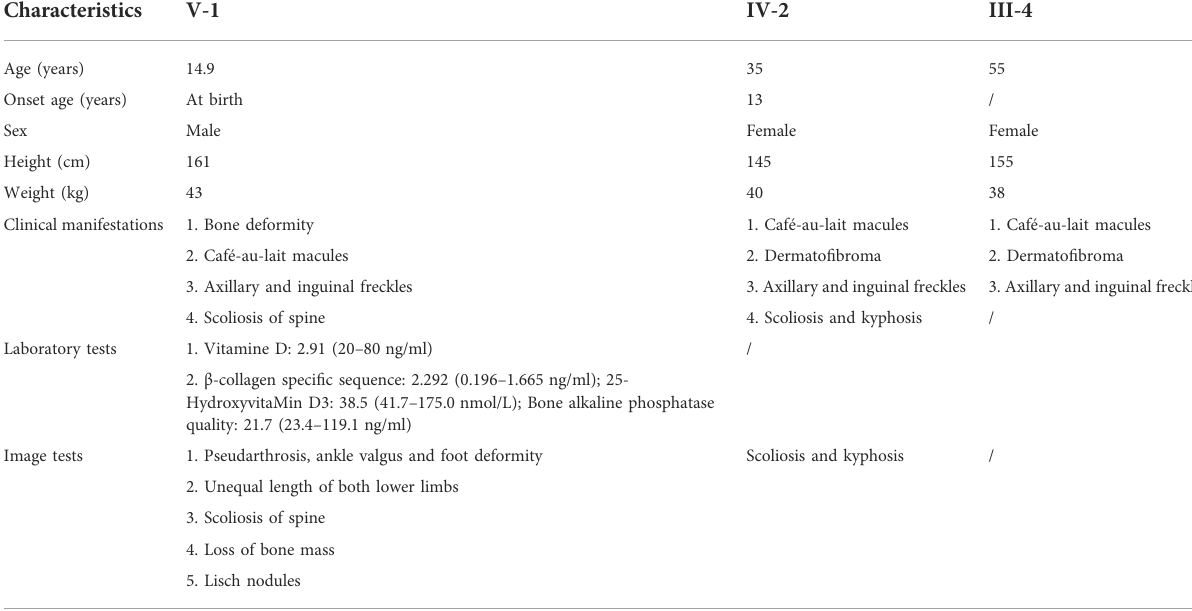
TABLE 1 Basic information, clinical manifestations, laboratory tests and image tests of the three affected members.